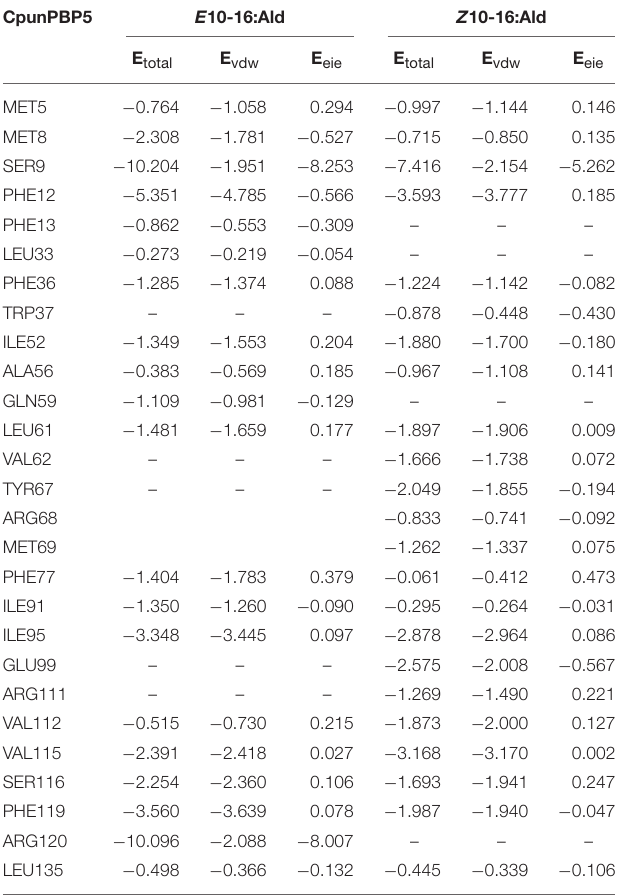
The binding affinities of mutant between proteins and sex